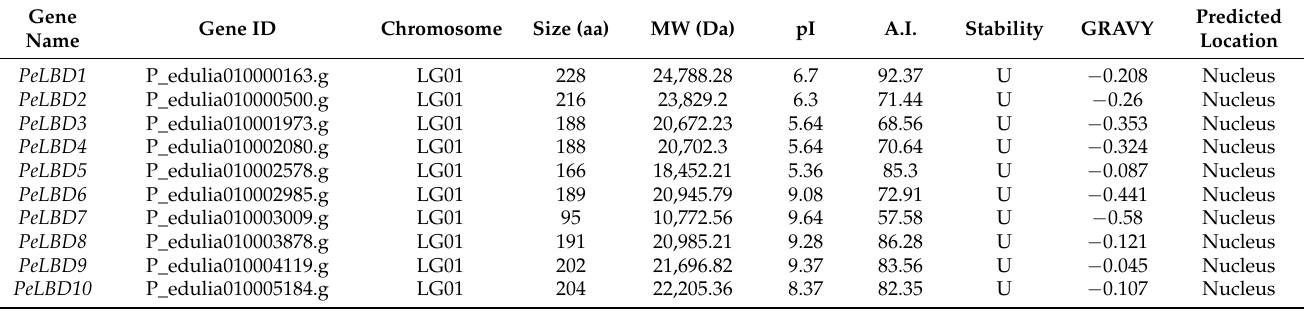
Table 1. Detailed information on 33 PeLBD genes of passion fruit and their encoded